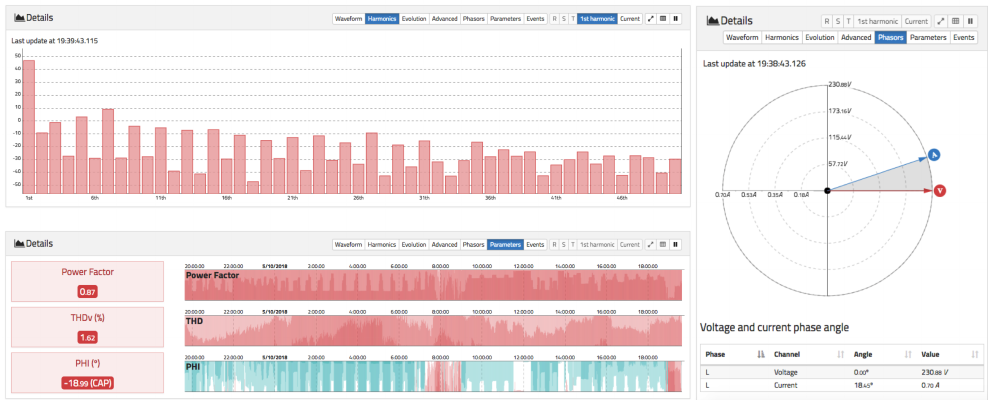
Figure 9. Advanced views of voltage tab (1). ( Top left ): real-time harmonic content for voltage. ( Bottom left ): 24 h of power factor, total harmonic distortion voltage (THDv), and phase angle. ( Right ): phasor representation for voltage and current.